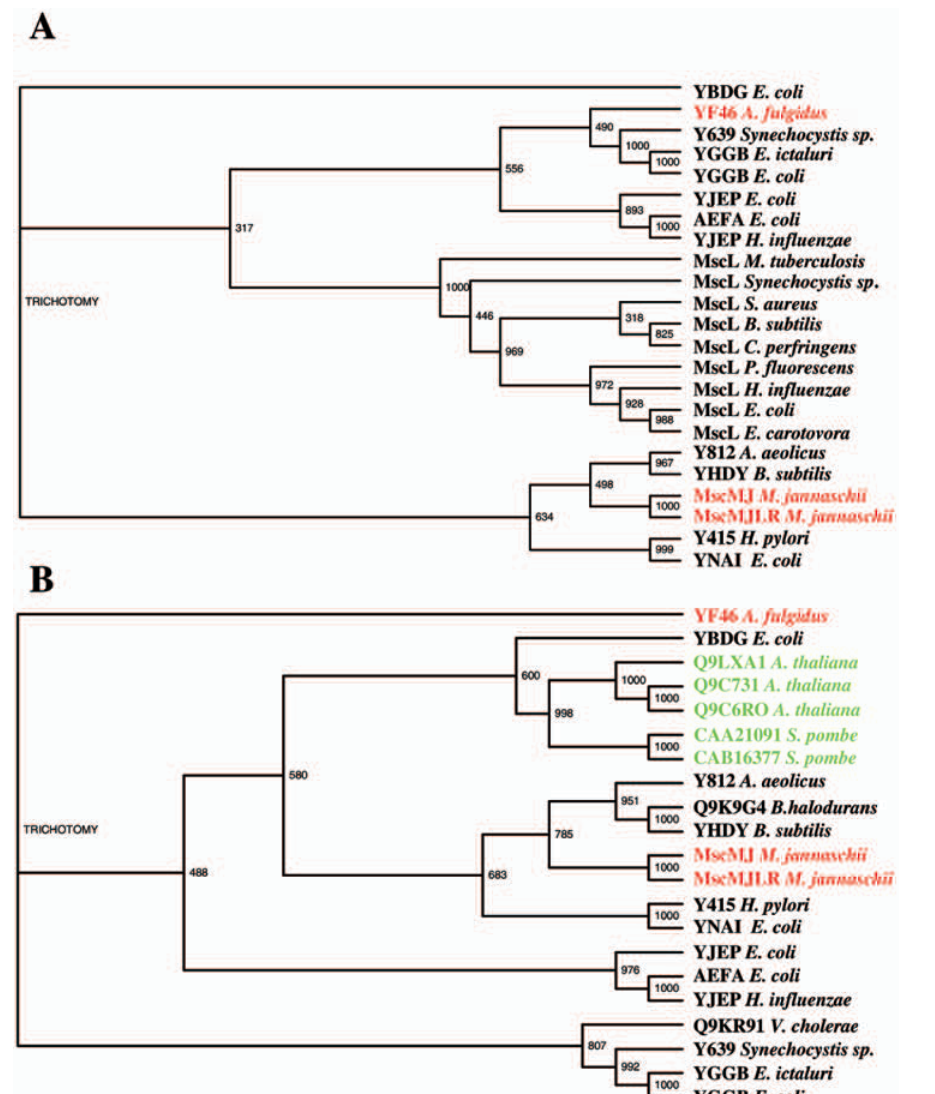
Figure 6. (A) Phylogenetic tree of complete aligned sequences of MscL and MscMJ homo- logs showing the common an- cestry of prokaryotic MS chan- nels. The archaeal homologs of MscMJ are highlighted in red. (B) Phylogenetic tree of complete aligned sequences of MscMJ and MscMJLR homo- logs showing the family rela- tionship between bacterial and archaeal MS channels, and pu- tative MS channels in A . thali- ana and S . pombe . The bacte- rial MS channel homologs of MscMJ and MscMJLR are de- picted in black; archaeal MS homologs are highlighted in red; and plant and yeast homologs are highlighted in green. The TM1 domain of E . coli MscL was used as a ge- netic probe to search the M . jannaschii genomic data- base for sequence similarity, leading to identification of MscMJ. Homologs of MscMJ and MscL were retrieved from the existing protein databases (GenBank, Protein DataBank and SwissProt) using BLAST (Altschul et al. 1997).